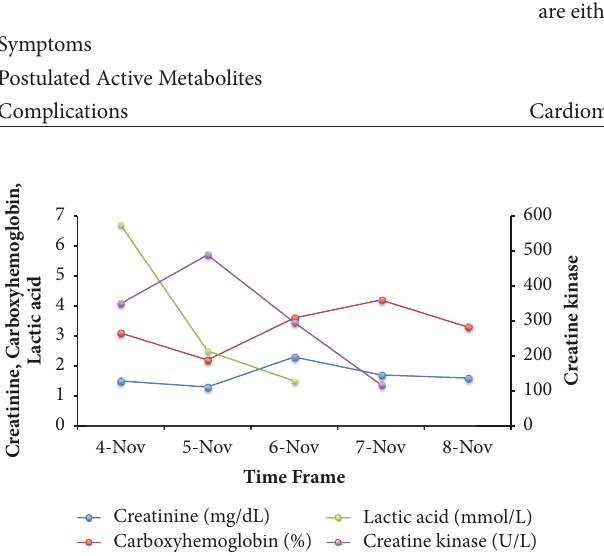
Figure 1: Lab trends during patient’s hospital stay. The left axis displays creatinine, carboxyhemoglobin, and lactic acid and the right axis displays creatine